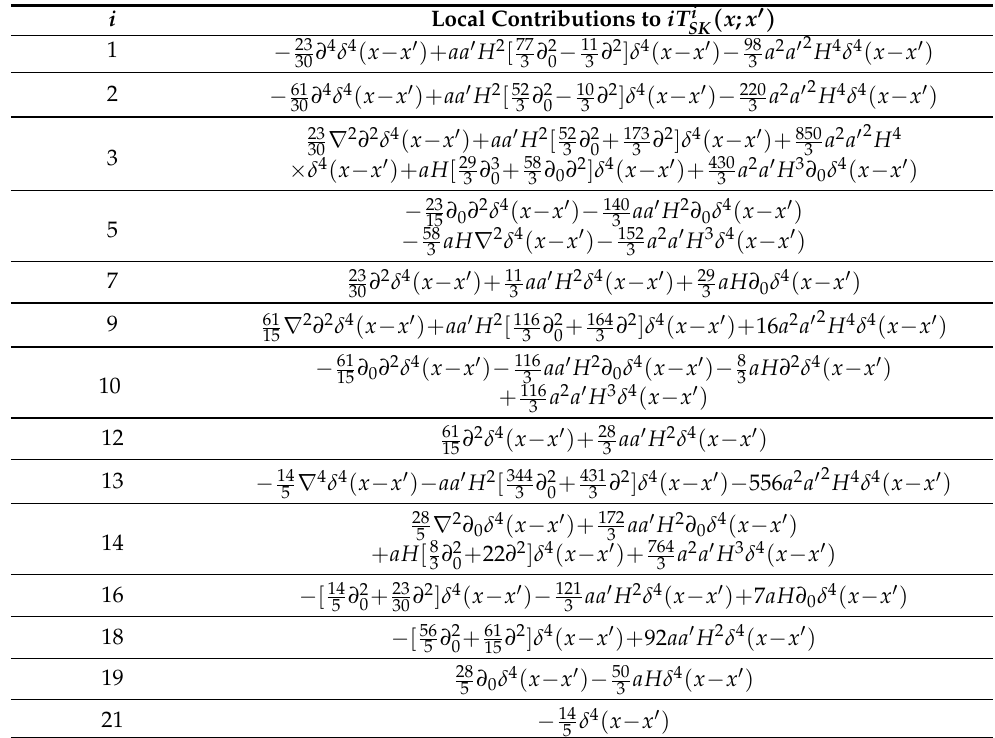
Table 8. Each of the tabulated terms must be multiplied by κ i Local Contributions to iT i